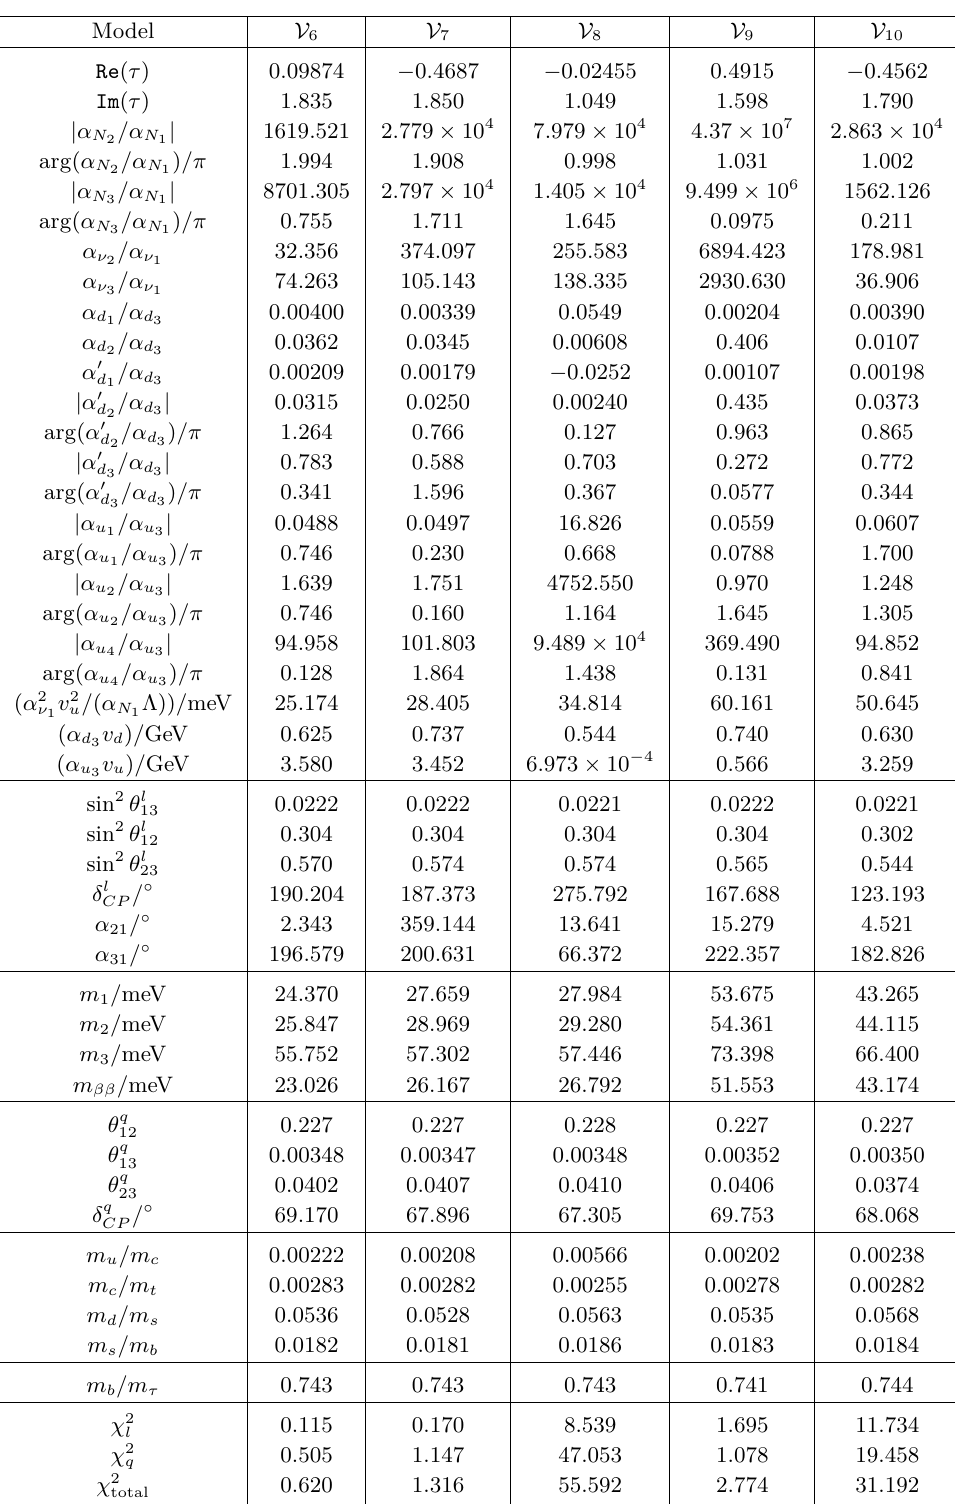
Table 10 . The best fit values of the free parameters and the corresponding predictions for lepton and quark mixing parameters and fermion masses for the phenomenologically viable models of Type-V (continuation of table